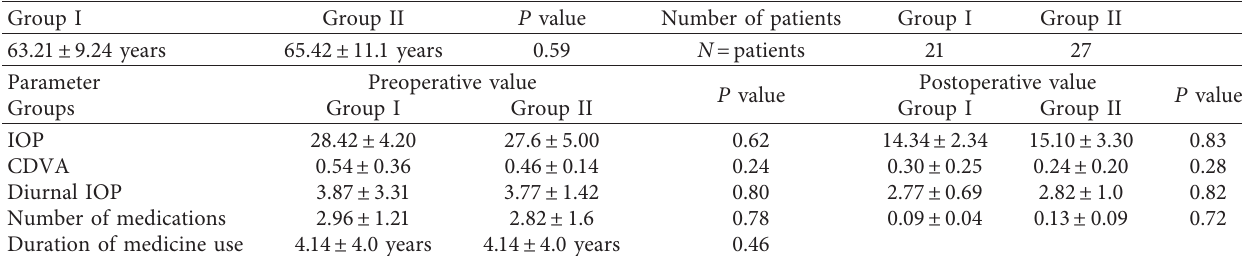
Table 2: Posttrabeculectomy cataract surgery patients: descriptive statistics.